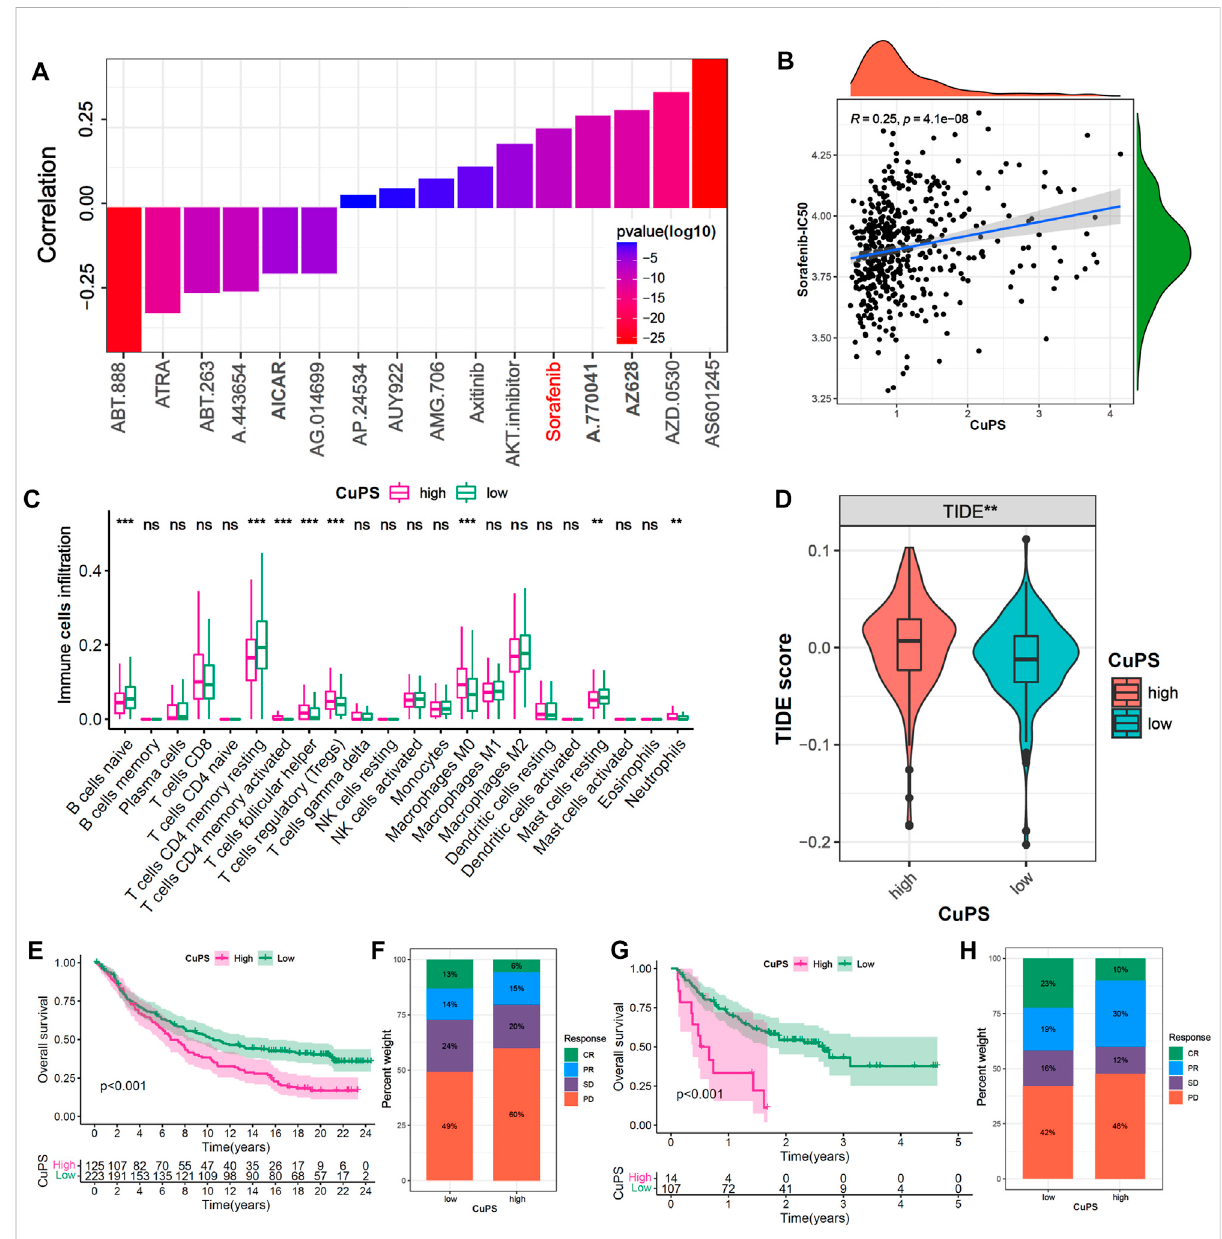
FIGURE 7 Ef fi cacy prediction of chemotherapy drugs and immunotherapy. (A) The correlation of Cu-PS with IC50 of drugs in GDSC database. (B) The correlation scatter plot of Cu-PS and Sorafenib-IC50. (C) The proportion of immunecells in TME between the high- and low- Cu-PS subgroups. (D) Comparison of TIDE score between the two Cu-PS subgroups. (E) Kaplan-Meier curves for high- and low- Cu-PS subgroups in the anti-PD- L1 immunotherapy cohort (IMvigor210). (F) The proportion of immune response (CR, PR, SD and PD) between two Cu-PS subgroups in IMvigor210cohort. (G) Kaplan-Meiercurvesforhigh-andlow-Cu-PS subgroupsintheanti-PD1immunotherapycohort(GSE78220cohort) (H) The proportion of immune response between two Cu-PS subgroups in GSE78220